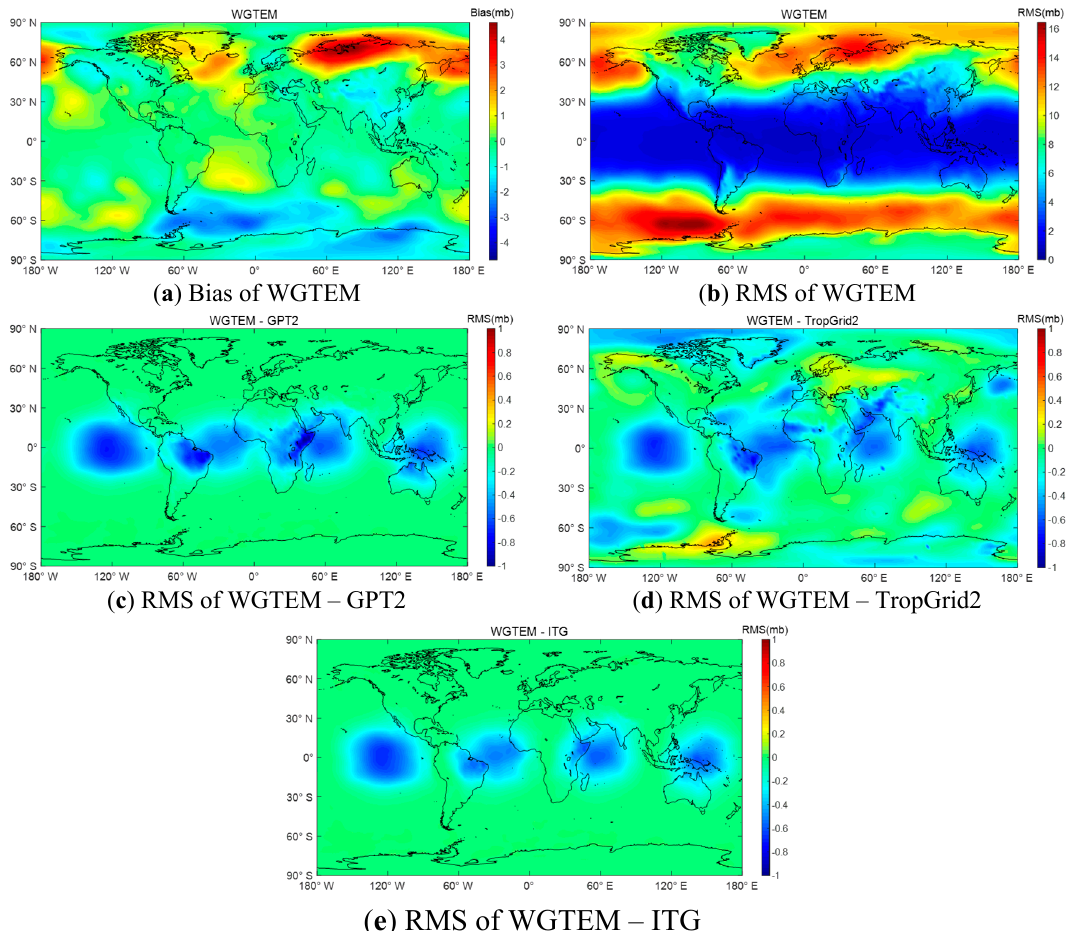
Figure 2. Global distribution of air pressure accuracy for WGTEM and global RMS di ff erences with other models, validated by ECMWF data.